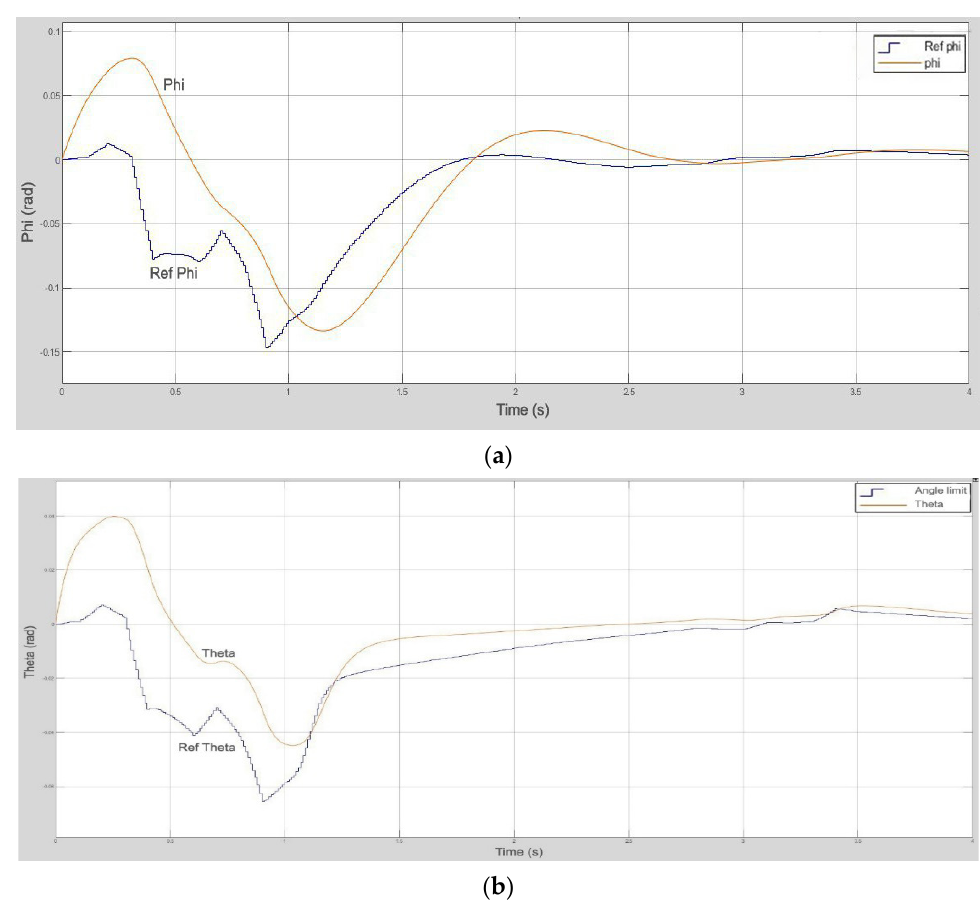
Figure 18. The return phi angle relative to the value set in the simulation. ( a ) The return phi angle relative to the value set in the simulation. ( b ) The return theta angle relative to the value set in the simulation. Figure 19 is a simulated image of the drone’s movement on the 3D xyz coordinate system, it can be seen that the orbits are close to each other and have very little deviation, the difference between the two orbits is very small, the two orbits are different each other is approximately 0.3 mm.